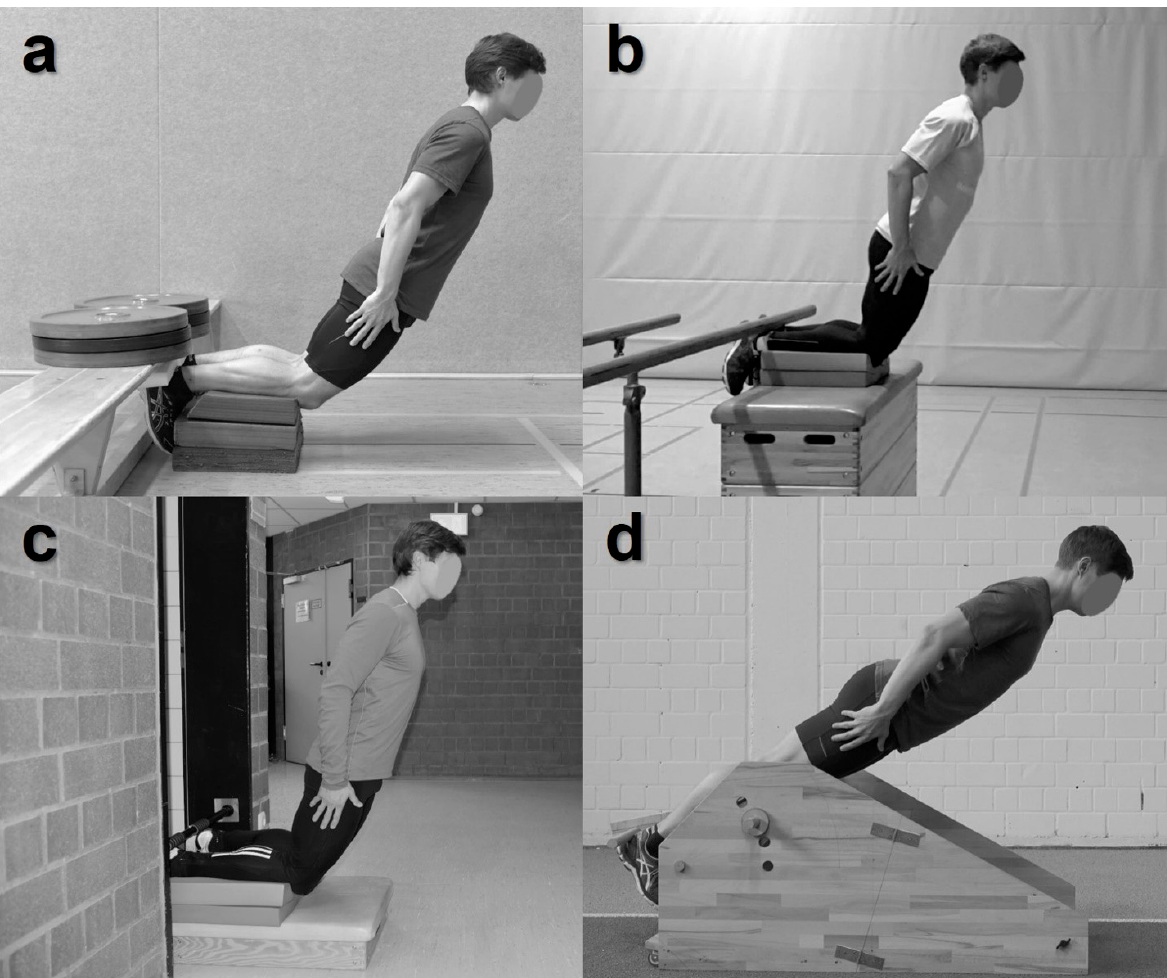
Figure 3. Representative Nordic Hamstring Exercise (NHE) training setups which provide fixed resistance to the heels, reasonable knee position, and expedient kneeling height: ( a ) appropriately weighted gym bench with cushion at the heels and at the shins (e.g., foam pads), ( b ) appropriately weighted bar, ( c ) doorway pull-up bar, and ( d ) a custom-made NHE device with modifiable shank inclination.